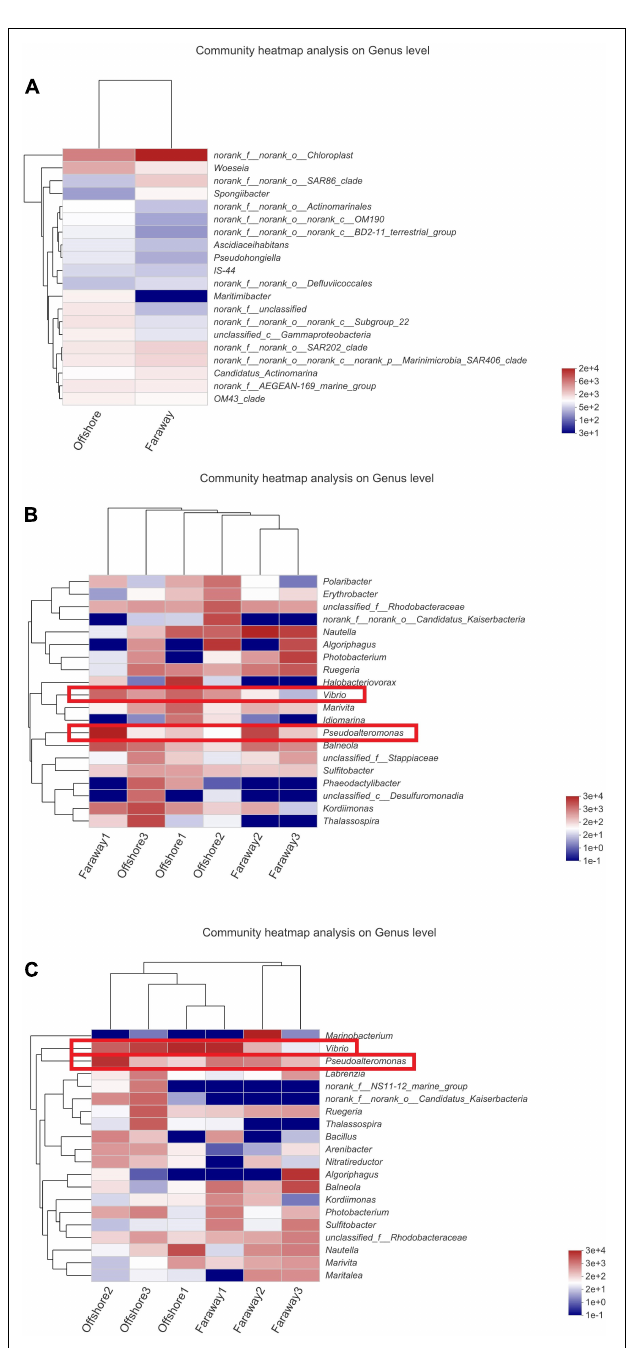
FIGURE 10 | Heatmaps of the major taxa identified on the initial day (A) , 15 days (B) , and 30 days (C) (Offshore represents the distance of 0.2 km from shore. Faraway represents the distance of 5 km from